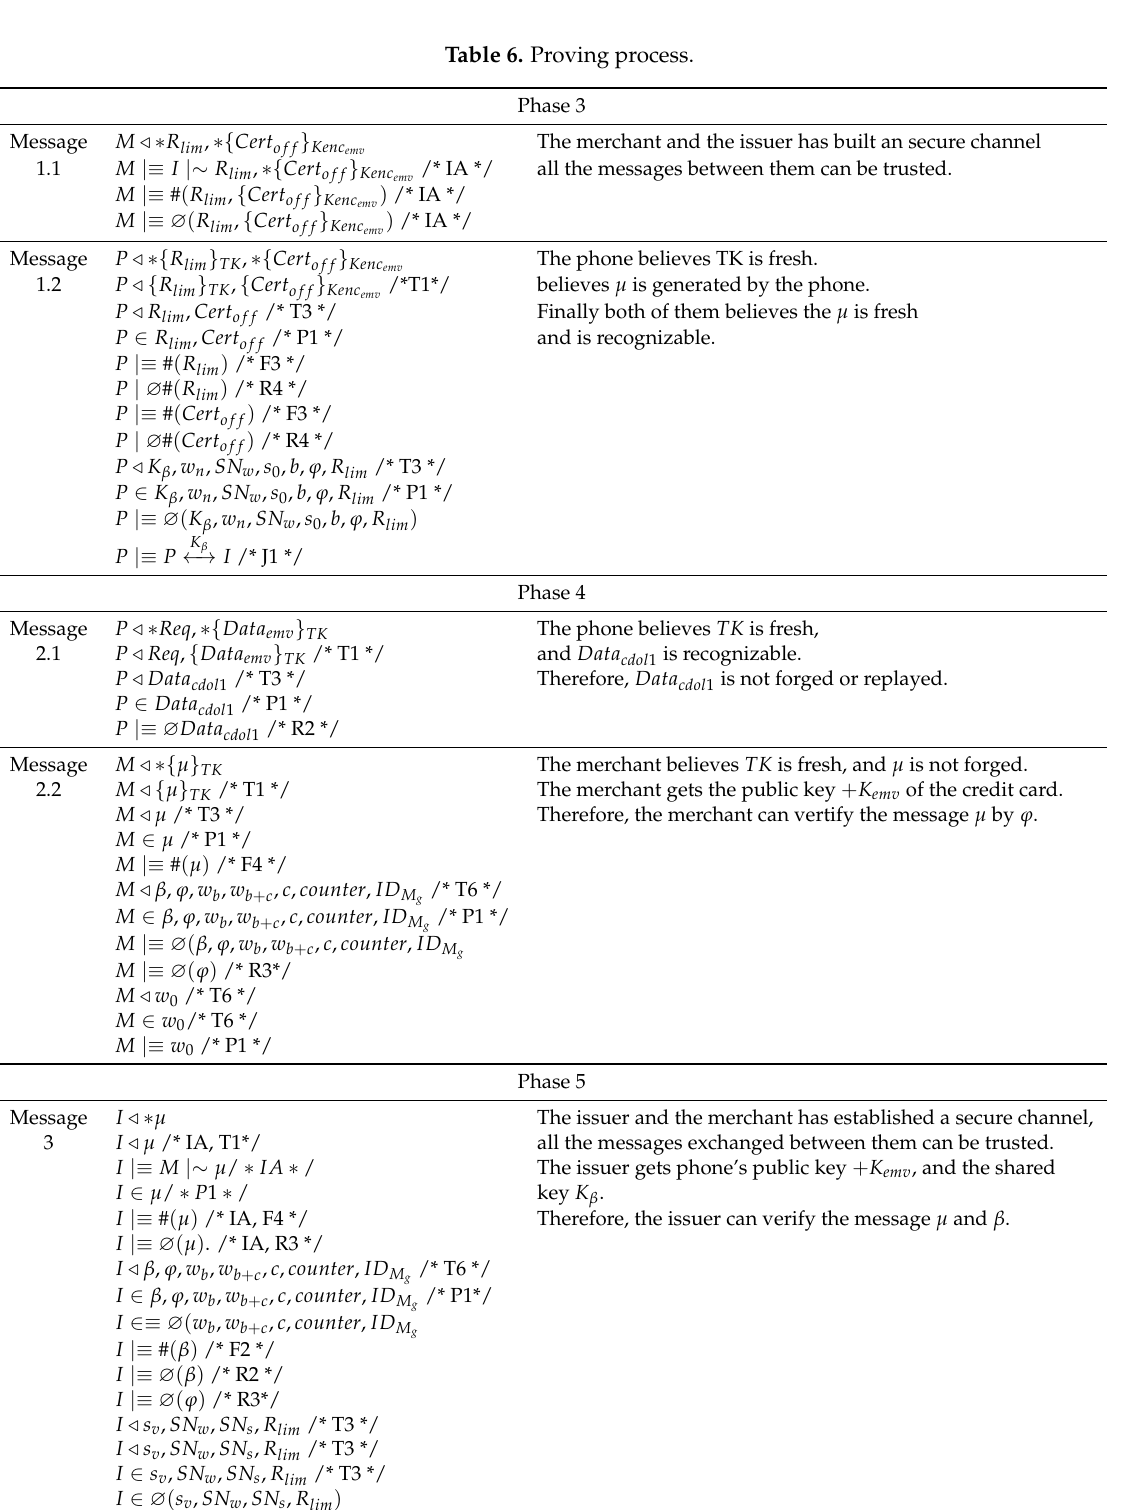
Table 6. Proving